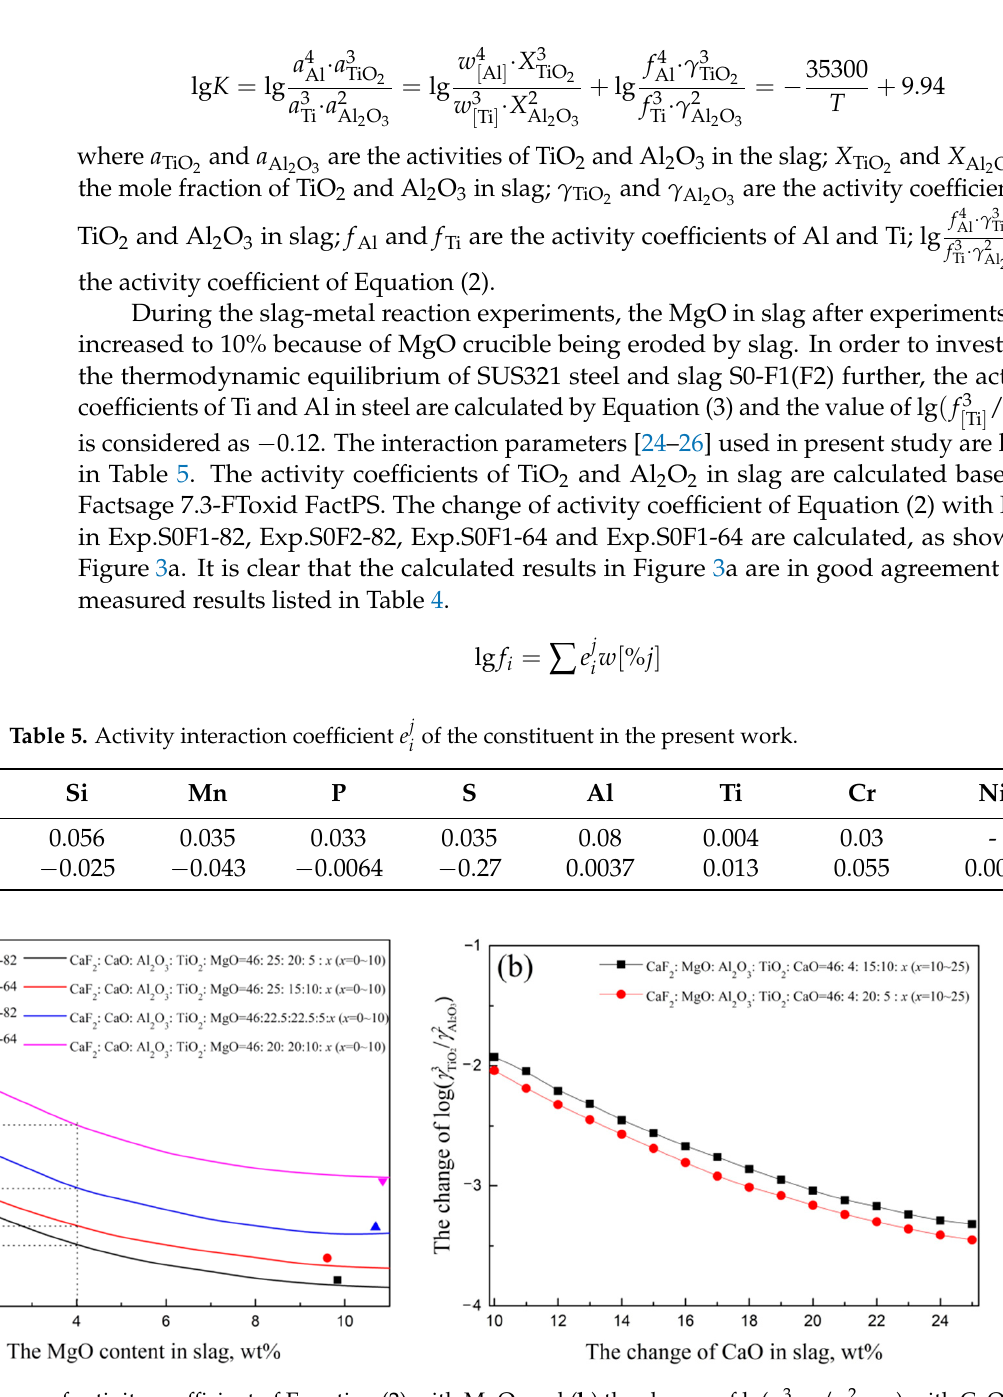
Figure 3. ( a ) The change of activity coefficient of Equation (2) with MgO, and ( b ) the change of lg( γ 3 CaO in slag calculated by Factsage. Figure 3a shows that the activity coefficient values of Equation (2) under slag S0:F1 = 8:2, S0:F1 = 6:4, S0:F2 = 8:2 and S0:F2 = 6:4 can be calculated as − 3.33, − 3.20, − 2.95 and −